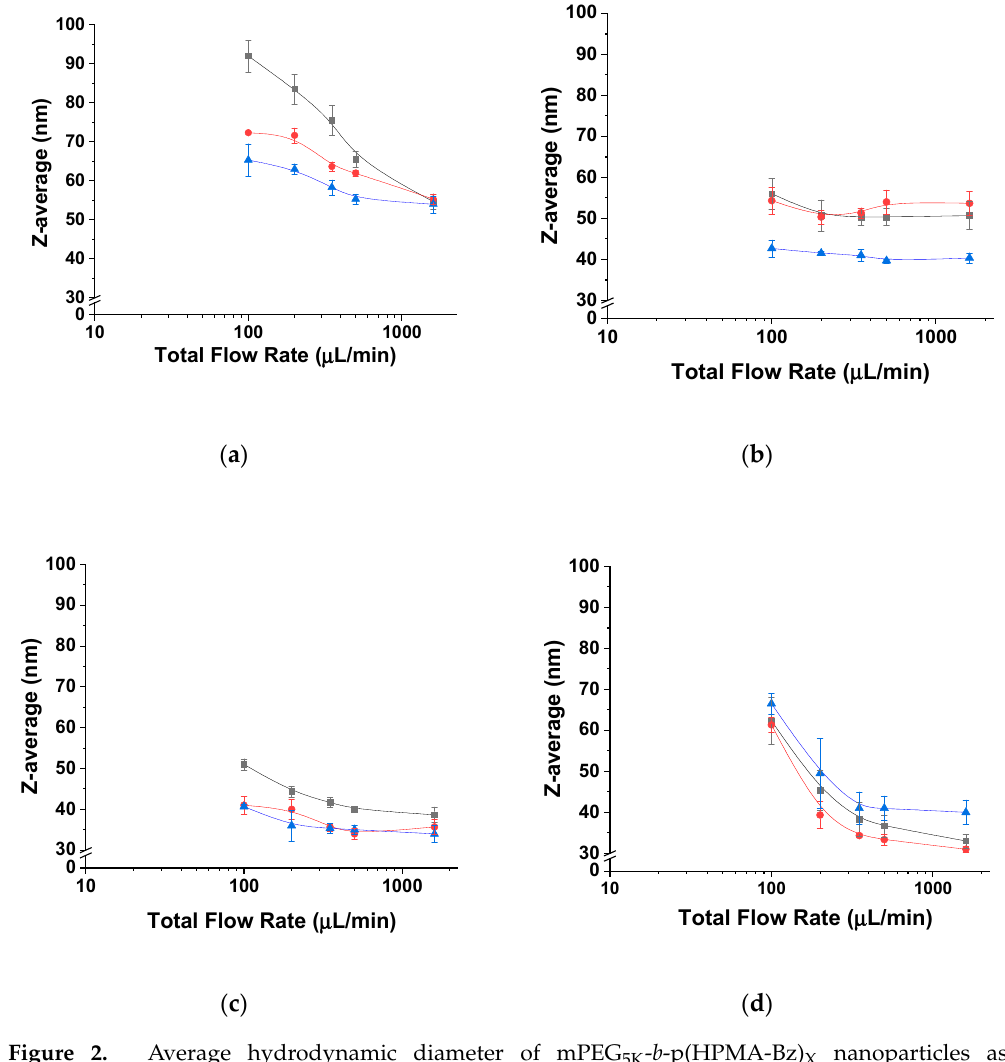
Figure 2. Average hydrodynamic diameter of mPEG 5K - b -p(HPMA-Bz) X nanoparticles as a function of flow rate. ( a ) mPEG 5K -b-p(HPMA-Bz) 17.1K , ( b ) mPEG 5K - b -p(HPMA-Bz) 10.0K , ( c ) mPEG 5K - b -p(HPMA-Bz) 5.2K and ( d ) mPEG 5K - b -p(HPMA-Bz) 2.7K . Black square: 5 mg / mL, red circle: 10 mg / mL and blue triangle: 20 mg / mL block copolymer in THF.